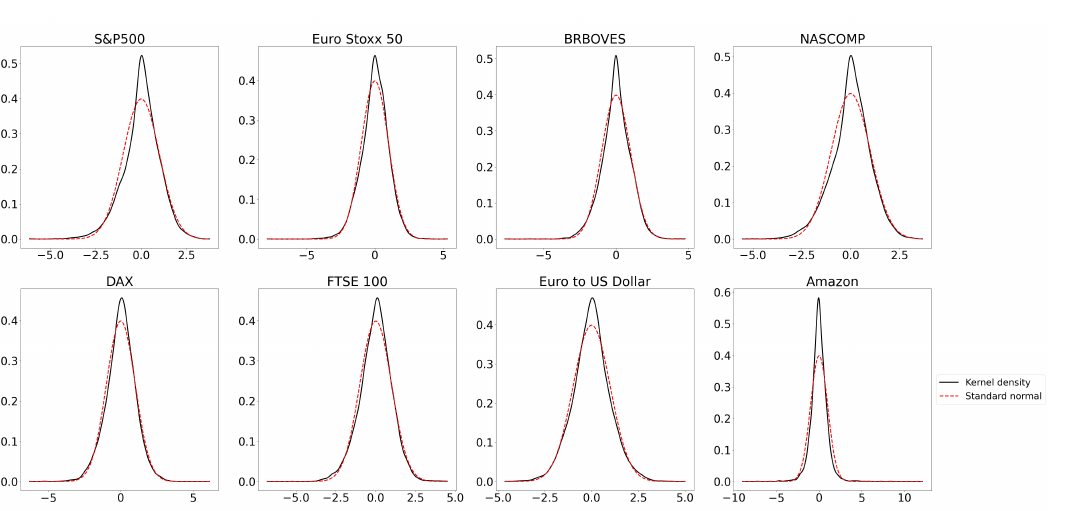
Figure 1. Kernel estimates of the probability density functions of the residuals ˆ Z t obtained with the normal model (part 1).